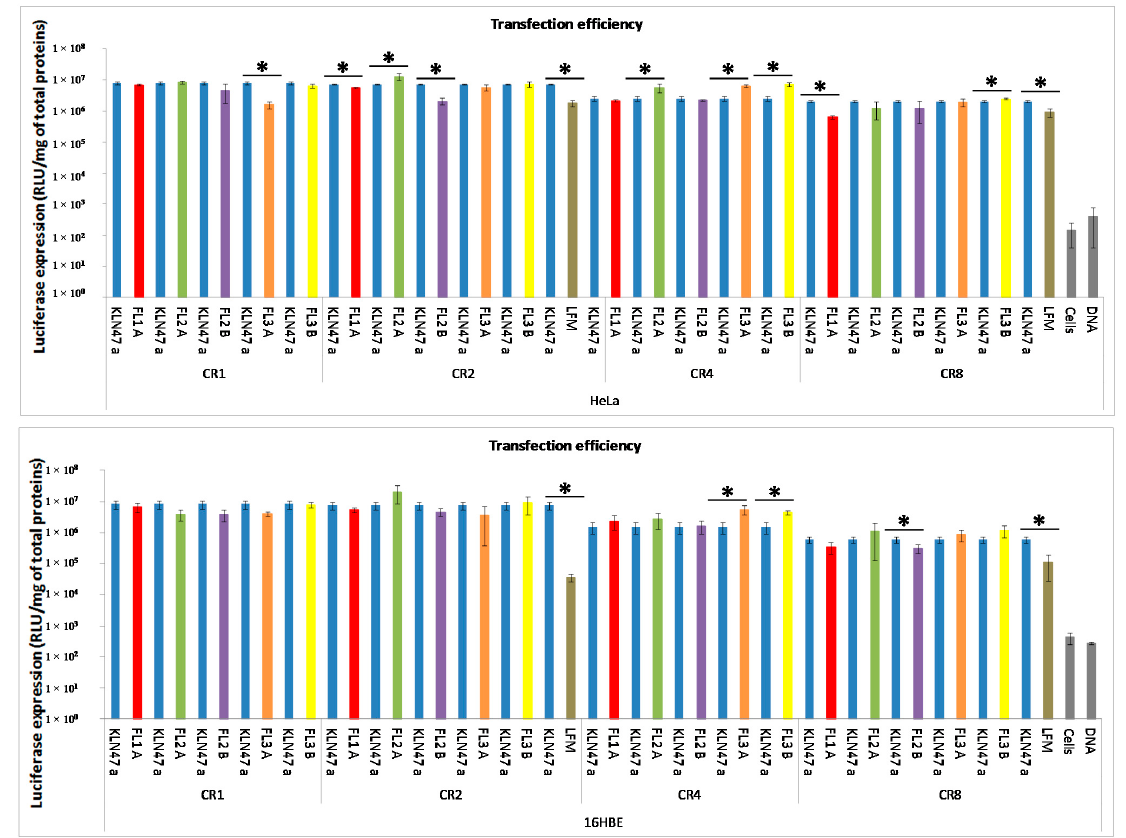
Figure 3. In vitro gene transfection efficiency of different formulations (CR ranging from one to eight) into cell lines A549, HeLa and 16HBE. The transfection procedure was performed as described in the Experimental section. The luciferase expression was measured 48 hours after deposition of lipoplexes onto the cells. Results were expressed as Relative Light Units (RLU)/mg of total proteins obtained with each formulation, reflecting their transfection abilities as the mean ± SD of three wells. Asterisk (*) indicates the significance difference of gene transfection efficiency between different formulations, as determined by an ANOVA test: * p < 0.05.